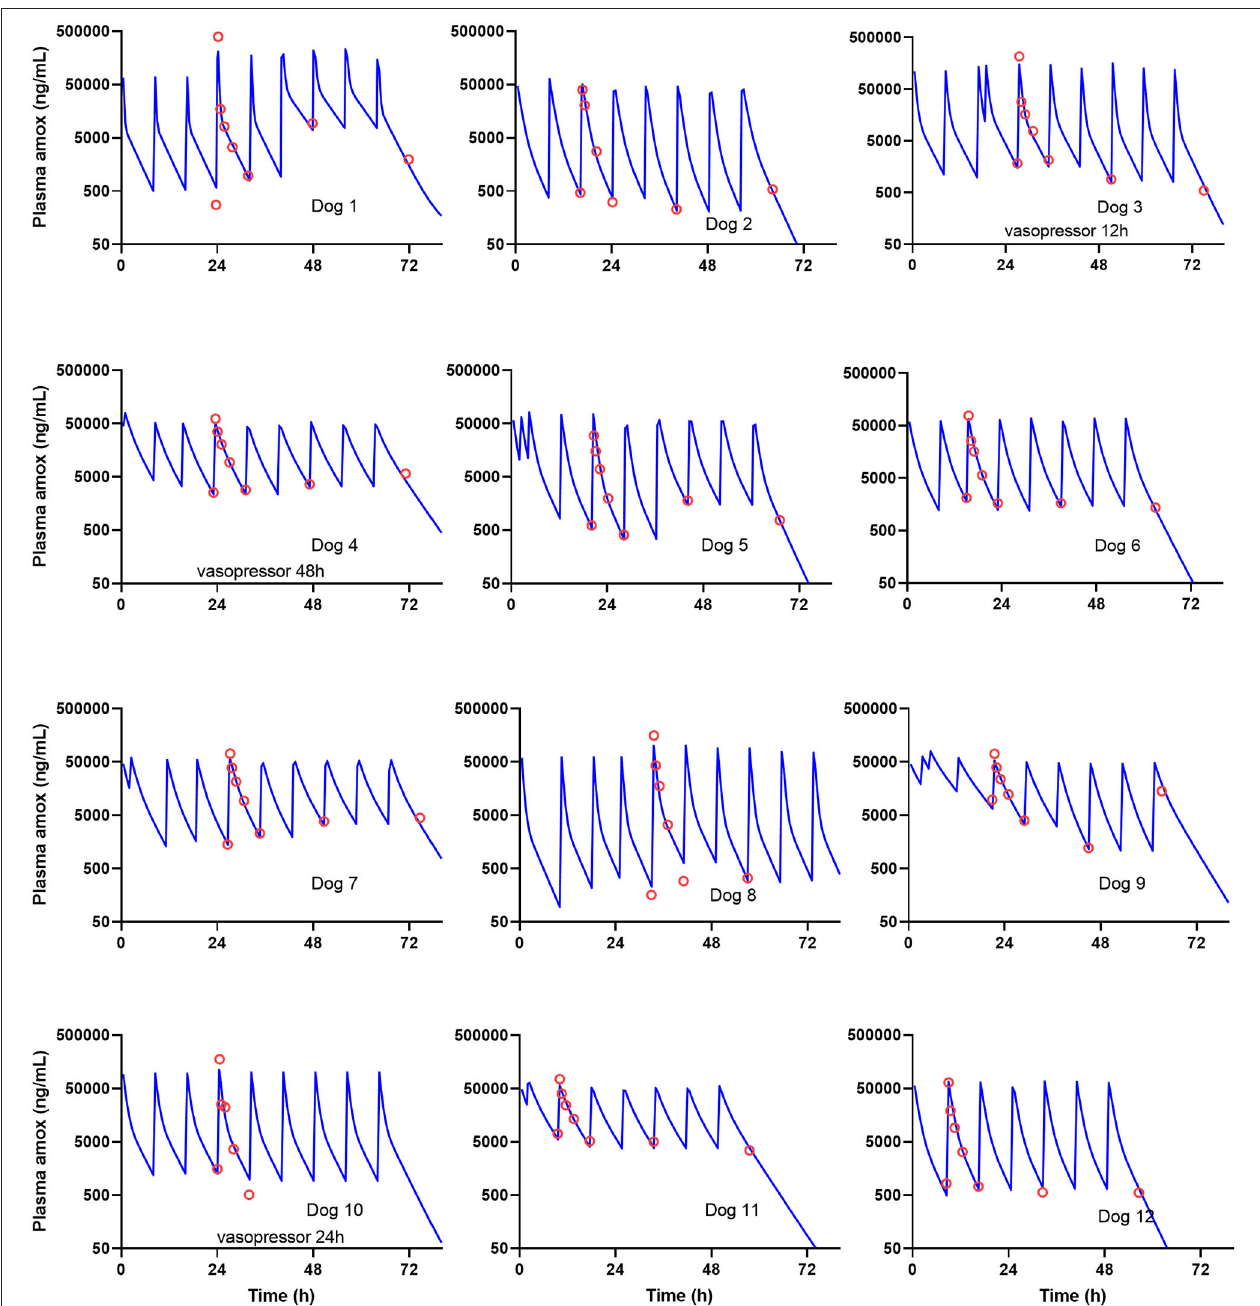
FIGURE 1 | Observed (red circles) vs. predicted (blue lines) concentrations for the 12 sick clinical dogs. Time 0h was the first recorded administration; the first plasma concentration was measured 16 to 24h thereafter. Trough variability was observed and modeled including between-occasion variability (BOV) in the pharmacokinetic (PK) model. Individual prediction, from 0 to 96h, was based on empirical Bayes estimates, i.e., post-hoc estimates of individual parameters.